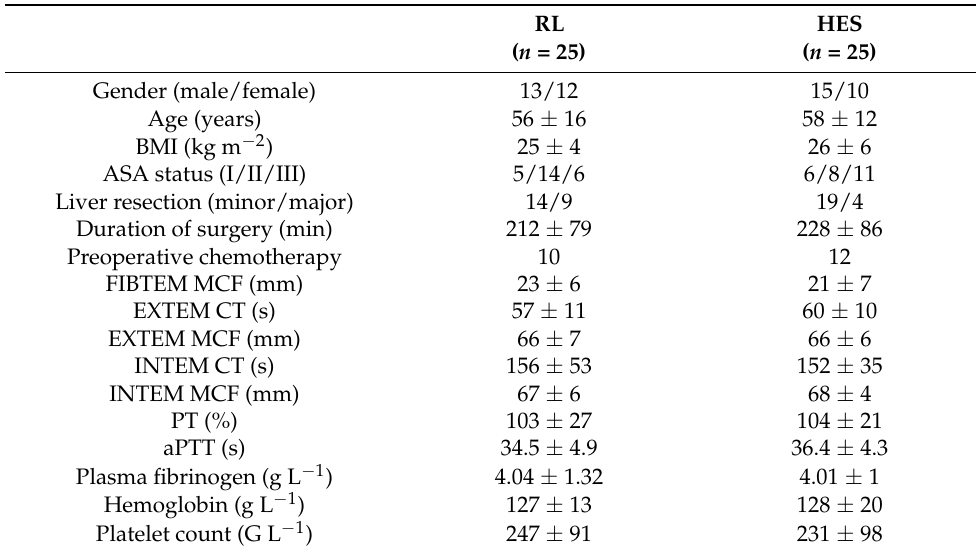
Figure 1. CONSORT flowchart depicting inclusion, randomization, and type of surgery (HES, hydroxyethyl starch; RL, Ringer’s lactate). Table 1. Patient characteristics, operative data, and baseline laboratory values. Values are number of patients or mean ± SD.